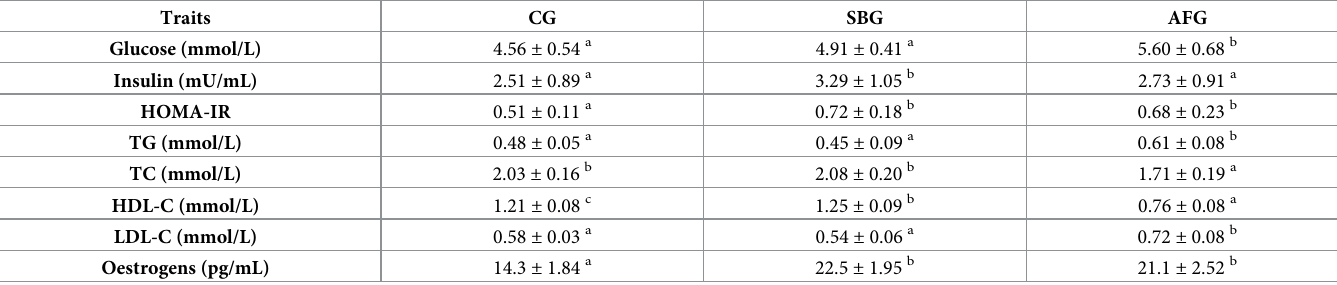
Table 5. Effect of sucrose content diet and alternating feeding on glucose, insulin, lipid concentrations and HOMA-IR value in the examined